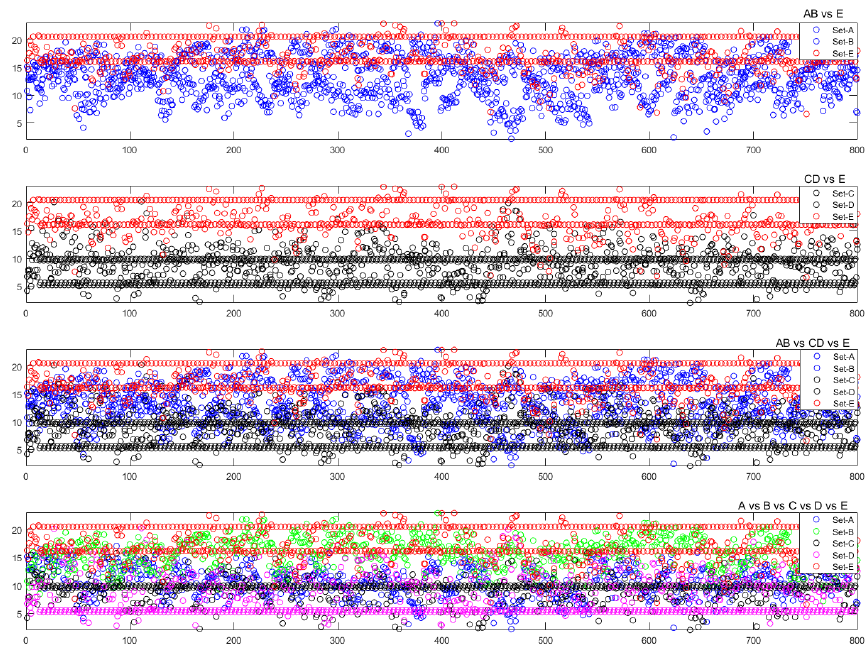
Figure 5. The first series of Mel-frequency cepstrum coefficients (MFCCs) in product function1 (PF1) of five sets (sets A, B, C, D, and E), for Case 1 to Case 4 from top-down.